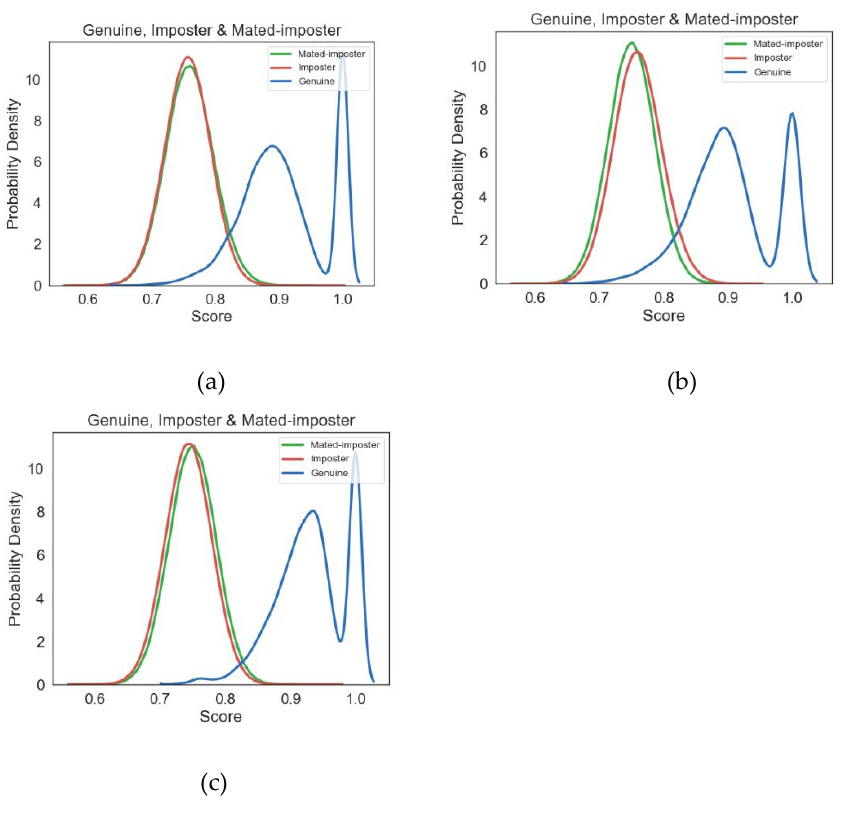
Figure 11. Revocability results from the proposed method on the ( a ) Ethnic, ( b ) IMDB Wiki, and ( c ) AR datasets.